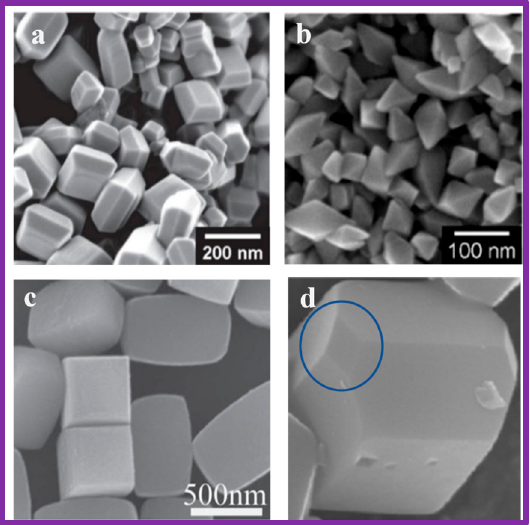
Figure 9. SEM images of crystals exposing different facets: ( a ) square {001} and trapezoidal {101} facets [39]; ( b ) triangular {101} facets in perfectly octahedral crystals [40]; ( c ) square {001} and rectangular {100} facets [37]; ( d ) square {001}, trapezoidal {101} and rhombus-shaped {110} facets [41]. Reprinted with permission from ref. [37,39–41].